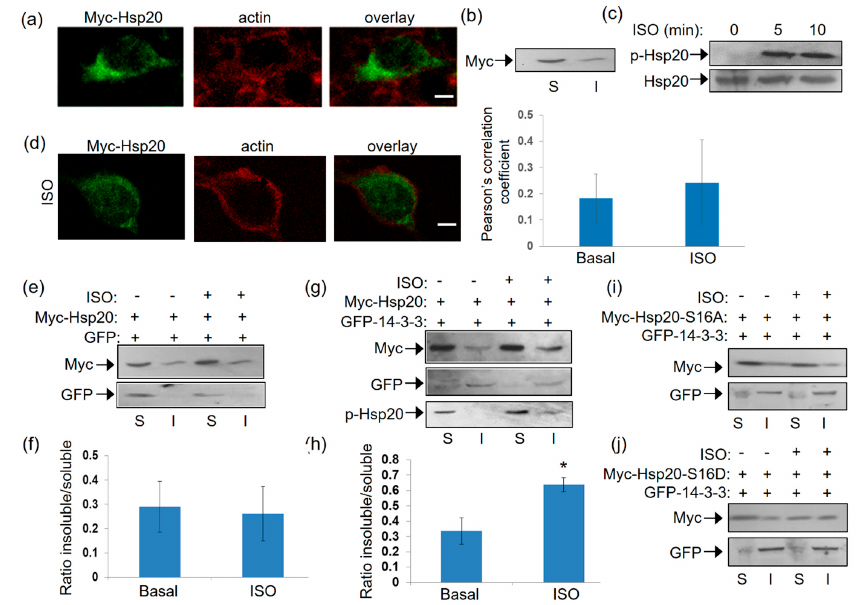
Figure 4. Localization of Hsp20 protein in HEK 293 cells and redistribution in the presence of 14-3-3. ( a ) Immunofluorescence analysis of HEK 293 cells transfected with myc-tagged-Hsp20 and examination of its localization with the cytoskeletal marker, actin. Scale bar 5 µ m. ( b ) Fractionation study of myc-Hsp20 and examination of its localization in cytosolic soluble (S) and cytoskeletal insoluble (I) cell fractions. ( c ) 1 µ M ISO treatment results in e ffi cient Ser16 phosphorylation of myc-Hsp20. ( d ) Immunofluorescence analysis of HEK 293 cells transfected with myc-tagged-Hsp20 and examination ofitslocalizationwiththecytoskeletalactinfollowingISOtreatment. CalculationofPearson’scorrelation coe ffi cient determined no significant alteration in the subcellular distribution of myc-Hsp20 following ISO treatment. Data are the mean ± SD; n = 15 cells from each group. Scale bar 5 µ m. ( e ) Fractionation of ISO treated HEK 293 cells transfected with myc-Hsp20 and GFP vector or ( g ) GFP-14-3-3 construct and determination of myc-Hsp20 subcellular location. ( f , h ) Quantification of myc-Hsp20 distribution in the presence of GFP or GFP-14-3-3 (* p < 0.05, t test, two-tailed; n = 3). Data are the mean ± SD. ( i ) Fractionation of ISO treated HEK 293 cells transfected with myc-Hsp20-S16A and GFP-14-3-3 or ( j ) myc-Hsp20-S16D and GFP-14-3-3 constructs and determination of their subcellular